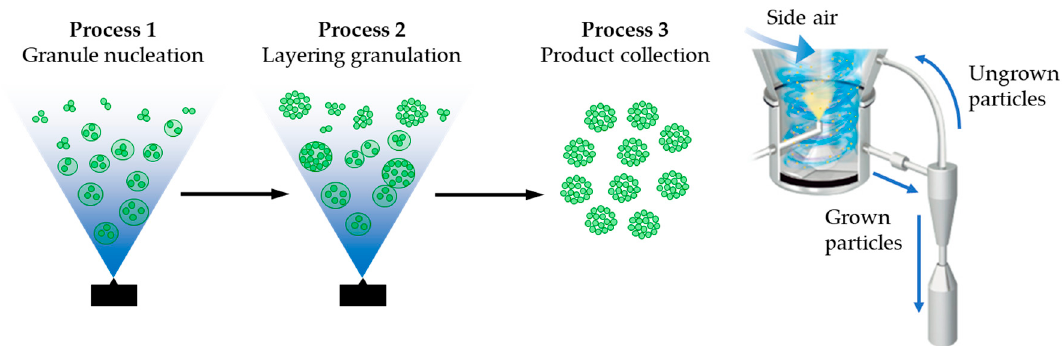
Figure 1. The circulation system of a continuous-spray granulator (CTS-SGR).